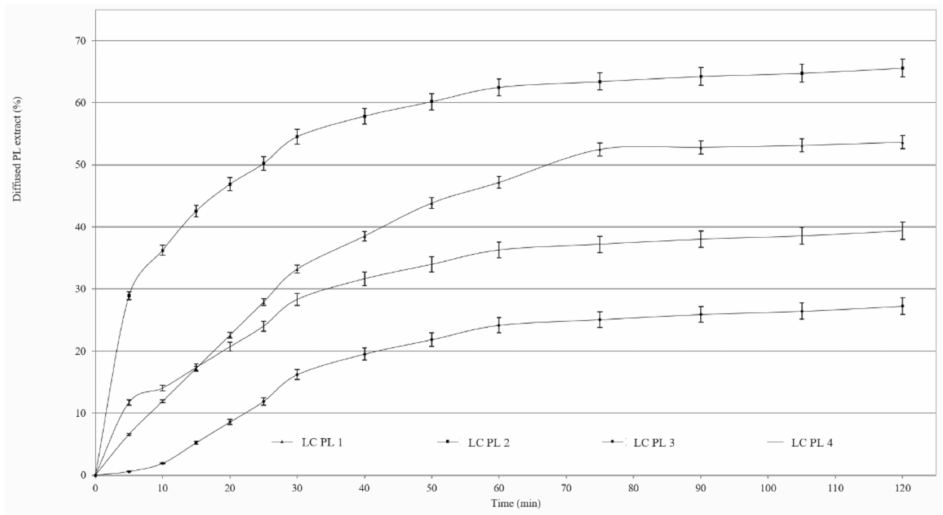
Figure 2. Release profiles of PL across isopropyl-myristate-impregnated cellulose acetate membrane of compositions